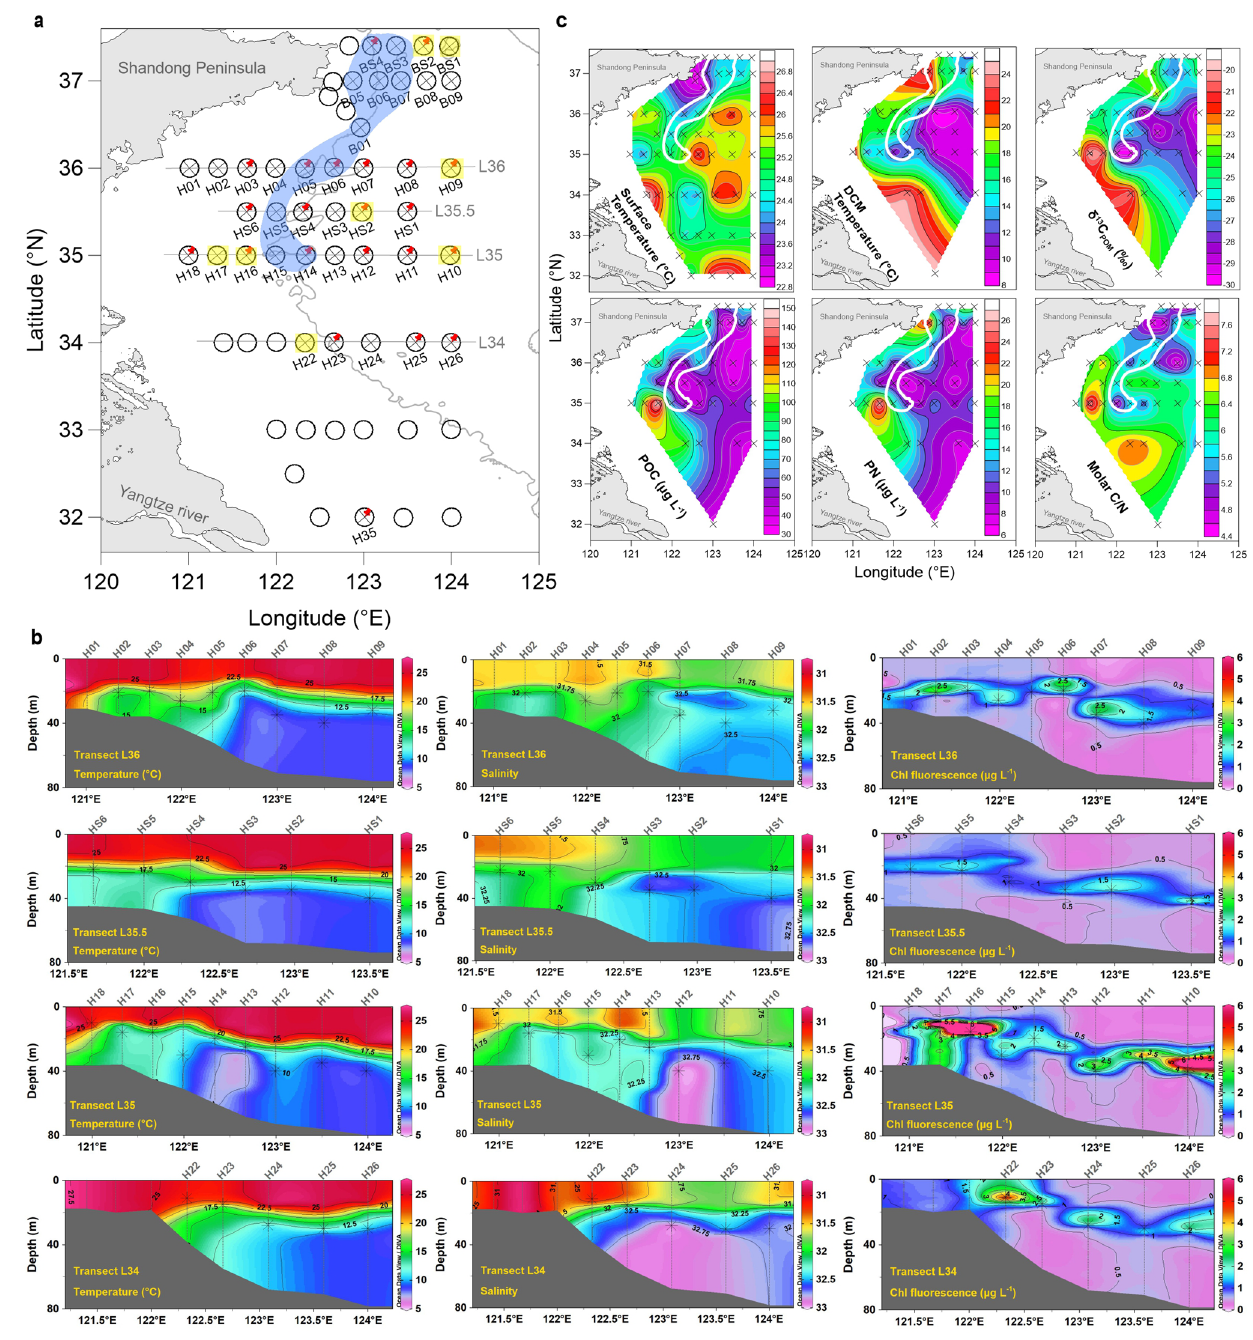
Fig. 1 Study area and spatial distribution of the hydrological and biogeochemical parameters. a Sample location in the southern Yellow Sea (SYS). Circles represent the hydrological stations, crosses are stations with distinct deep chlorophyll maxima (DCM) layers, and red pins indicate stations where [CO 2aq ] in the DCM layer is concurrently obtained. The solid gray line is the 50-m isobath. δ 13 C POM in two DCM stations (H01 and H24) will not be discussed further in this study, since the seawater sample at the DCM layer of H01 was not collected, and the fi lter at H24 contains less than 50 μ gC, which will introduce error for the δ 13 C POM measurement. b Vertical distribution of temperature, salinity, and chlorophyll fl uorescence in four latitudinal transects of middle SYS as marked in ( a ). The dark stars indicate the location where suspended particles were collected. The strong strati fi cation and position of the Yellow Sea Cold Water Mass (YSCWM) can be clearly seen from the structures of temperature and salinity. The upwelling fronts in the western boundary of the YSCWM area can be recognized from temperature pro fi les. Chl fl uorescence pro fi les clearly demonstrate the existence of the DCM layer. Source data for ( b ) is available in Supplementary Data 2. c Horizontal distribution of temperature in both surface and DCM layer, and elemental and stable carbon isotopic composition of particulate organic matter in the DCM layer. Note that the DCM is the depth at which the data was collected. The polygon marked by a white line represents the location of the cyclonic gyre.